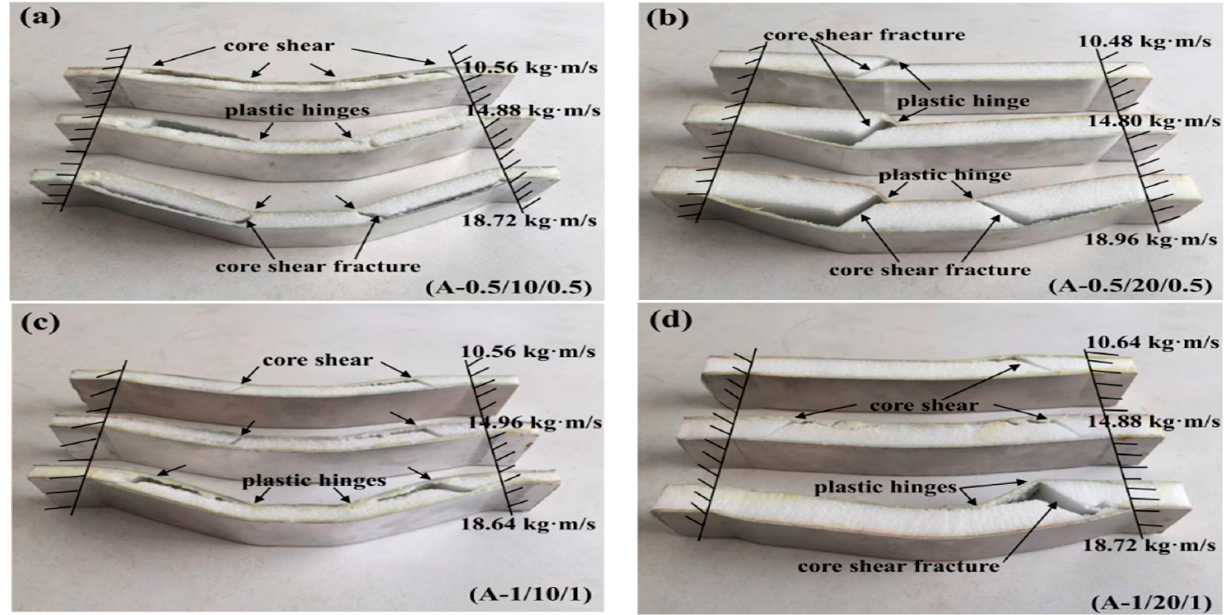
Figure 5. The impact force–time curves of the sandwich beams: ( a ) A-(0.5/10/0.5); ( b ) A-(0.5/20/0.5);